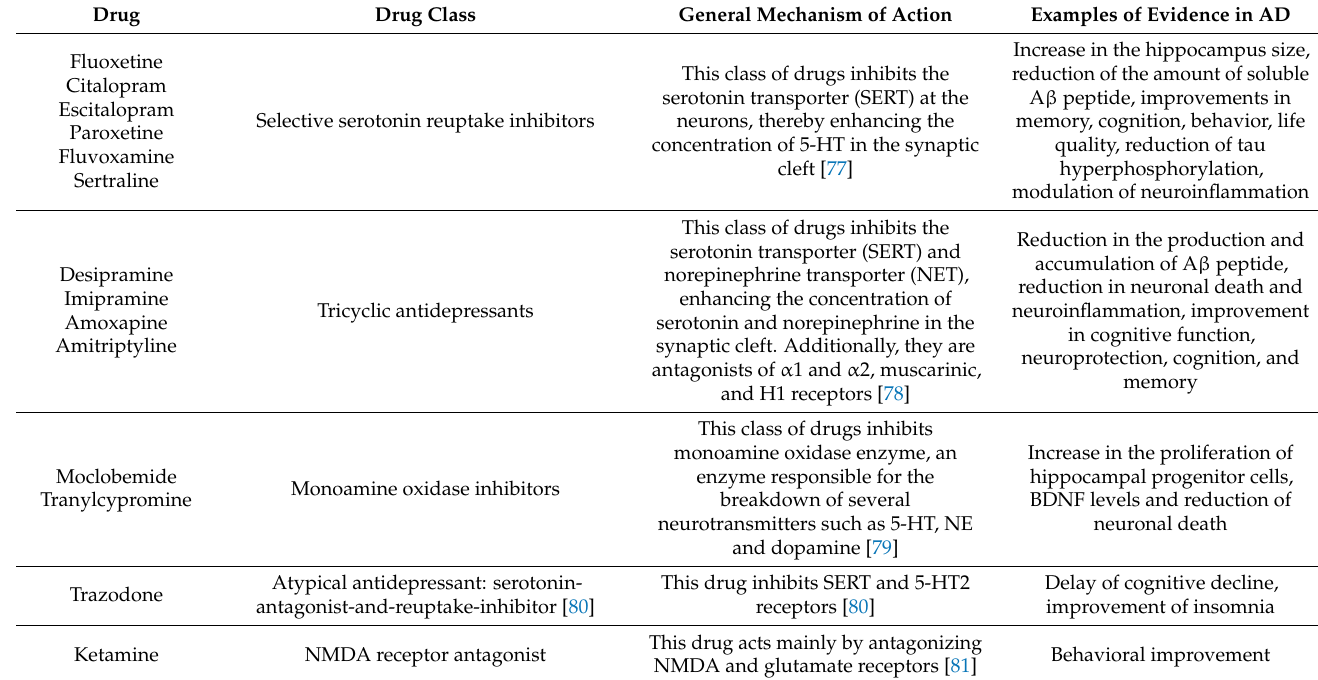
Table 1. Summary of the antidepressants addressed in this review, highlighting some evidence in AD and the general mechanism of action, by drug